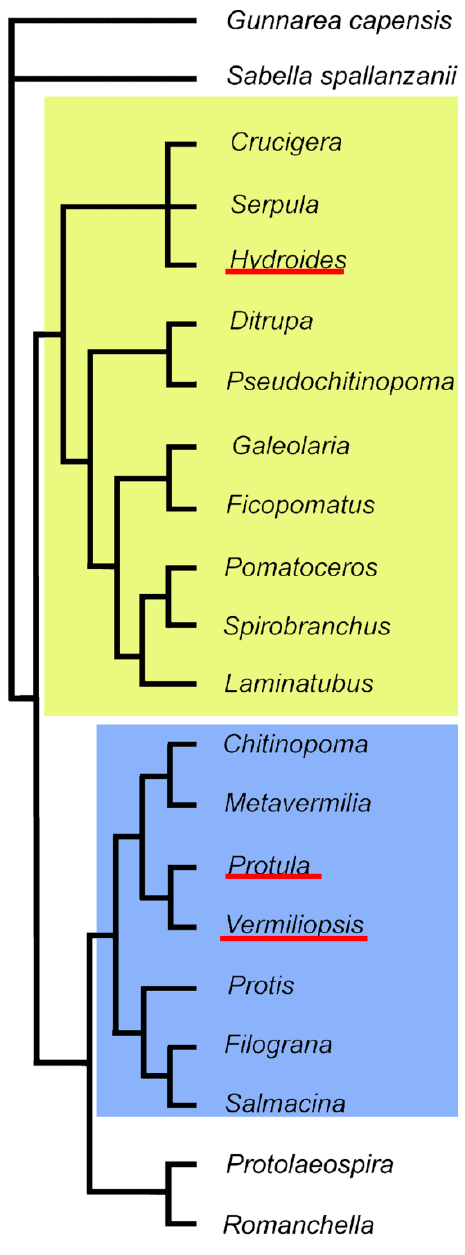
Figure 1. Phylogeny of serpulids. Studied genera are underlined. Dominantly calcitic serpulids are marked with yellow and dominantly aragonitic serpulids with blue modified after Vinn [11].